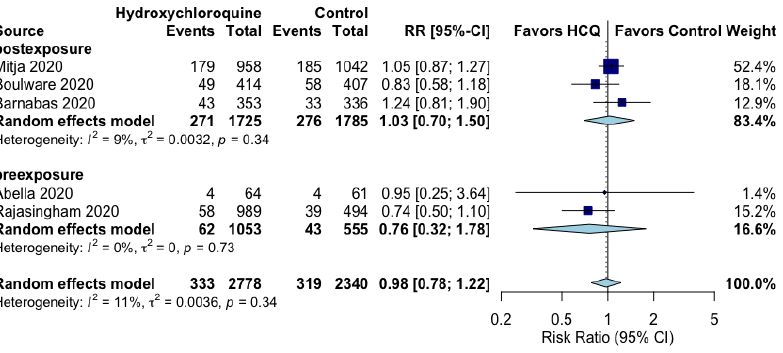
Figure 2 . Effect of prophylaxis with hydroxychloroquine on COVID-19 infection (either RT-PCR SARS-Cov-2 positivity or symptoms compatible with COVID-19).